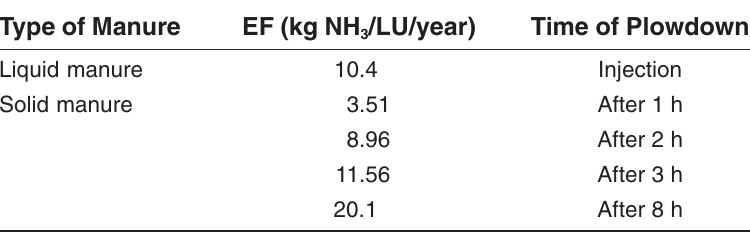
The Comparison of Emission Factors from the Application of Liquid and Solid